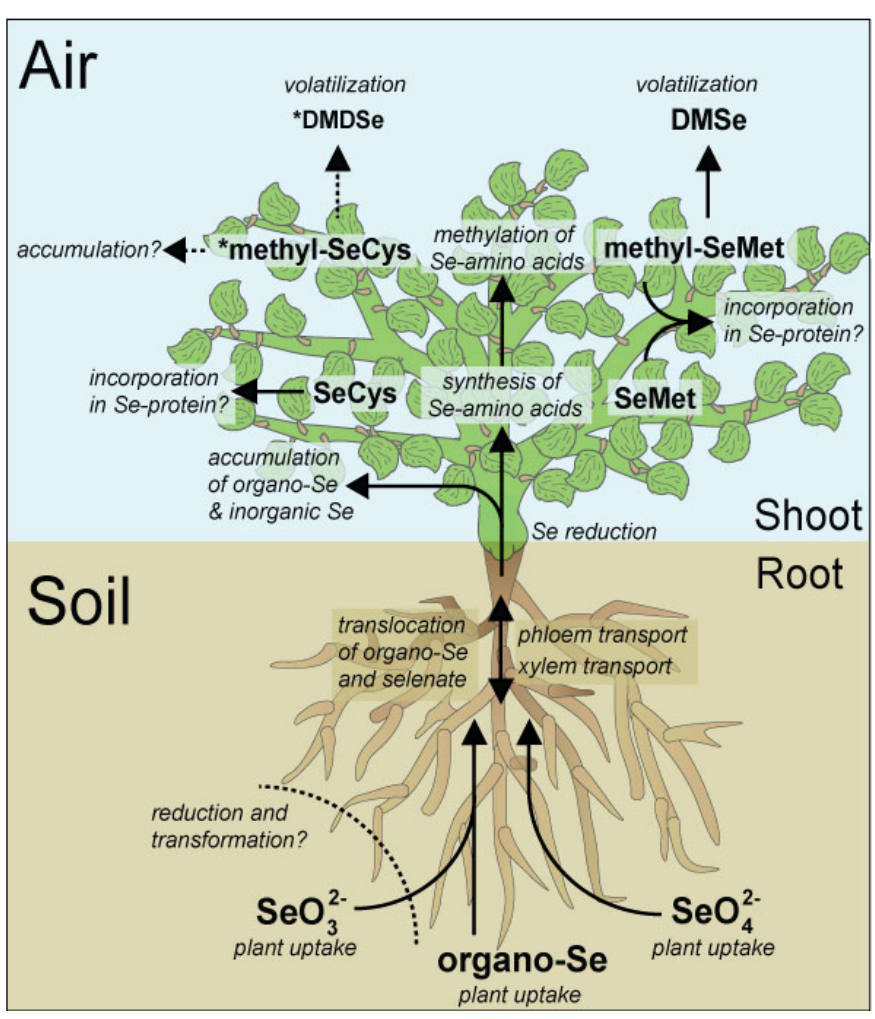
Figure 3. Overview of major pathways of Se at the soil-plant-atmosphere interface. The transport- and transformation processes of Se in higher plants are indicated in italics at the corresponding arrows. Compounds indicated with an asterisk are thought to only occur in Se-accumulator